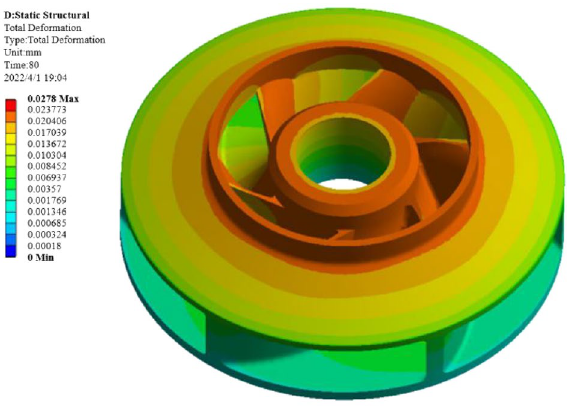
Figure 14. Analysis results under A2B4C1D3 process parameter